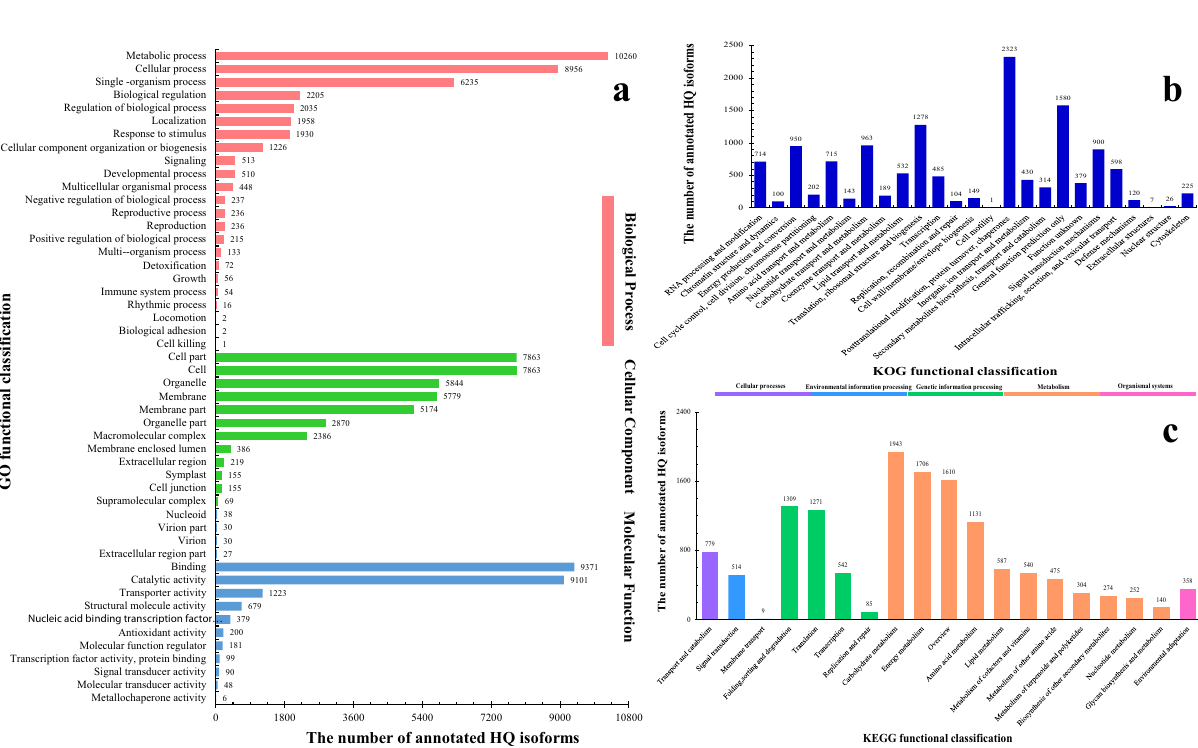
Figure 3. Gene ontology (GO), eukaryotic orthologous groups (KOG) and Kyoto encyclopedia of genes and genomes (KEGG) functional classifications of high-quality (HQ) transcripts. ( a ) GO classification of HQ transcripts. ( b ) KOG classification of HQ transcripts. ( c ) KEGG classification of HQ